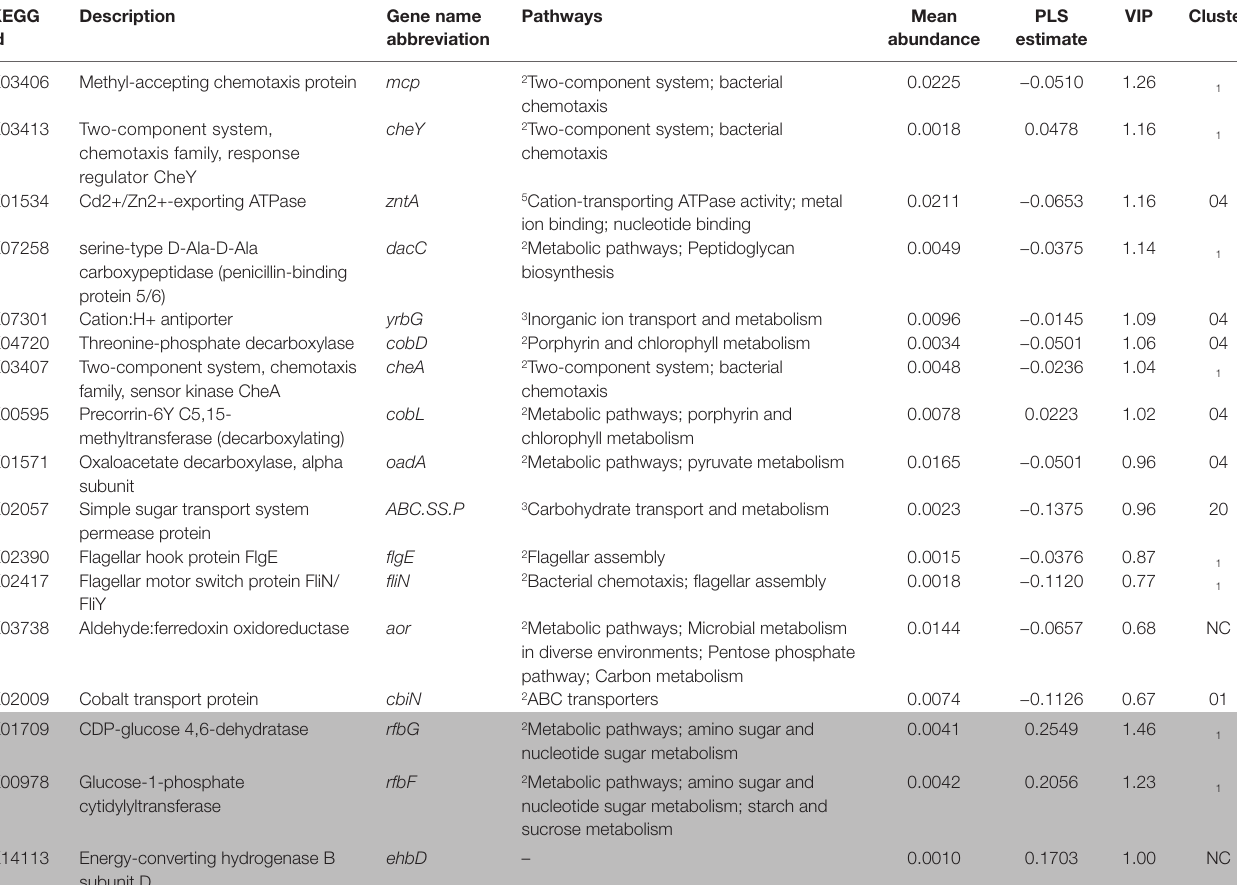
TABLE 4 | Summary of microbial genes identified for the prediction of RFI. KEGG